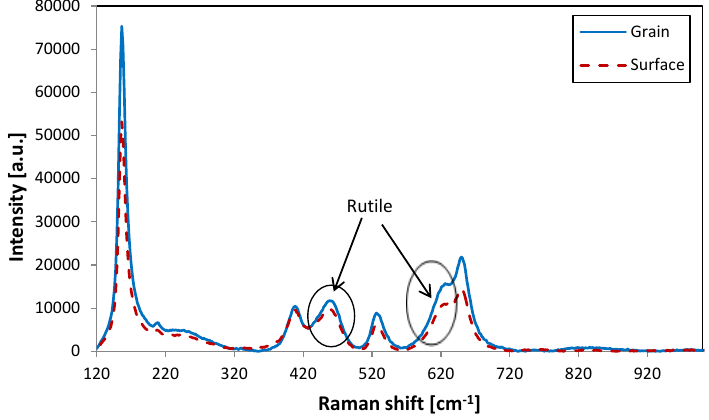
Figure 5. Raman images of sample annealed at 700 °C. Red-collected from surface, blue-from